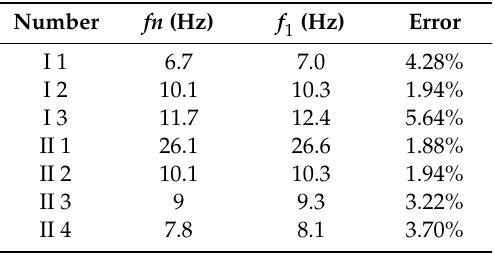
Table 4. Parameters of comparison result of f n and f 1